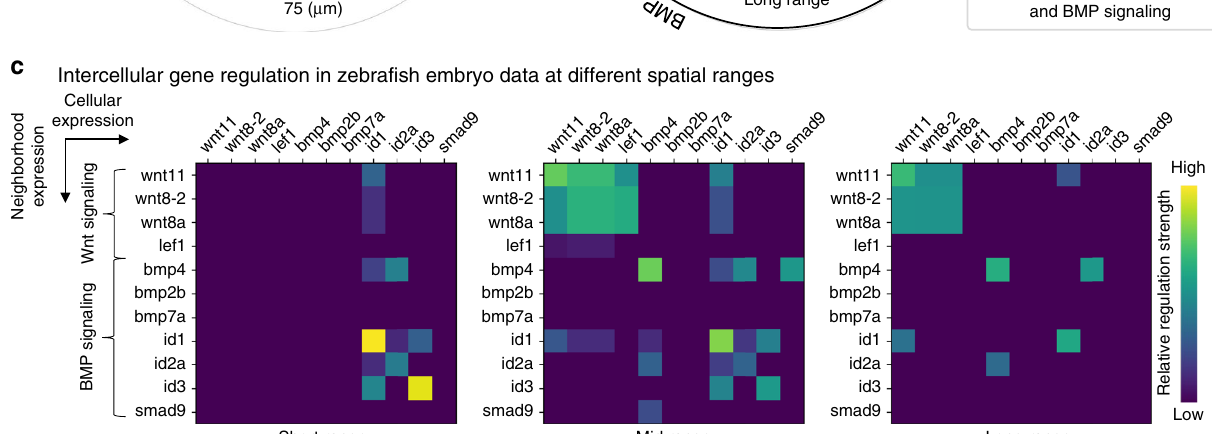
Fig. 5 Intercellular gene – gene regulatory information fl ows. a ( Drosophila embryo) The intercellular gene – gene regulatory information fl ow for the top 20 variable genes in Drosophila embryo scRNA-seq data. For example, gene Twist in the 25 μ m shell is connected with gene Snail (red curve), suggesting Snail is directly or indirectly affected by Twist in neighbor cells within a spatial distance of 25 μ m. b (zebra fi sh embryo) The intercellular gene – gene regulatory information fl ow for the variable genes involved in Wnt signaling or BMP signaling. Relative distances are considered where short, medium and long range corresponds to 1/8, 1/4 and 1/2 of the embryo radius. c Heatmaps of the information fl ows at different spatial scales showing the intercellular regulation within and across the two signaling